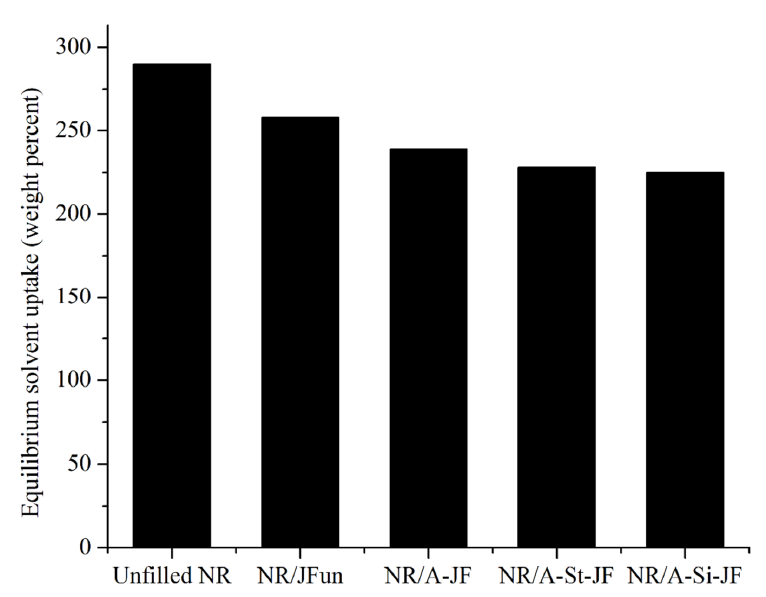
Figure 9. The values of equilibrium solvent uptake of different NR composites.